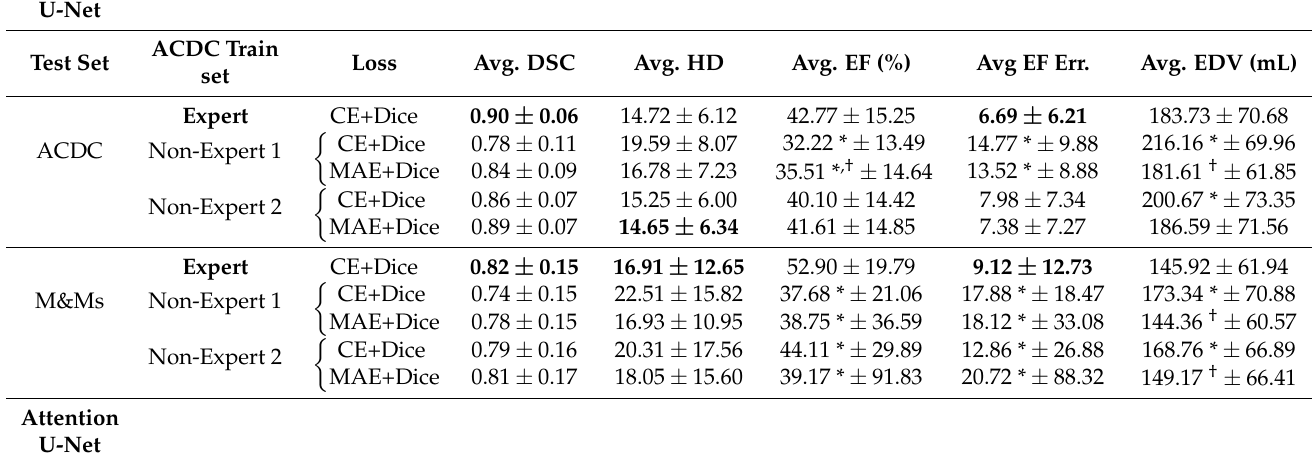
Table 3. Dice score, Hausdorff distance, average ejection fraction (EF) error, and end diastolic volume (EDV) for the right ventricular cavity for U-Net, Attention U-Net and E-Net with expert and non-expert annotations with data